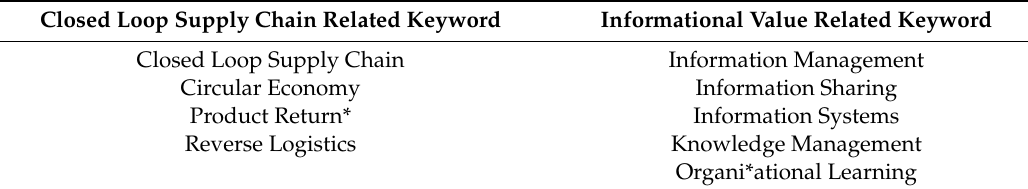
Table 1. Key words used for article search.